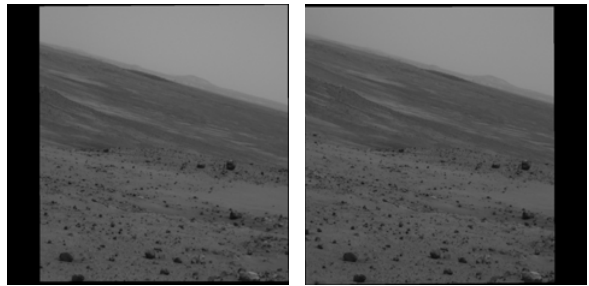
Figure 2. A stereo pair of Pancam images acquired by Spirit rover